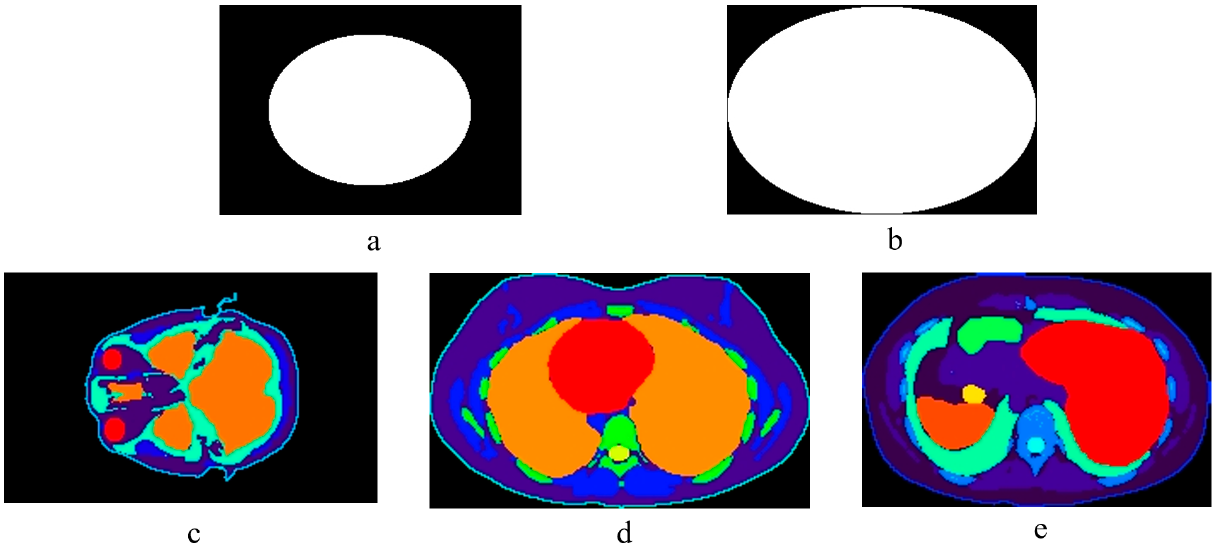
Figure 2. Image tasks considered in this work. ( a ) Head-equivalent water phantom, ( b ) body-equiv- alent water phantom, ( c ) adult head, ( d ) adult thorax and ( e ) adult abdomen.